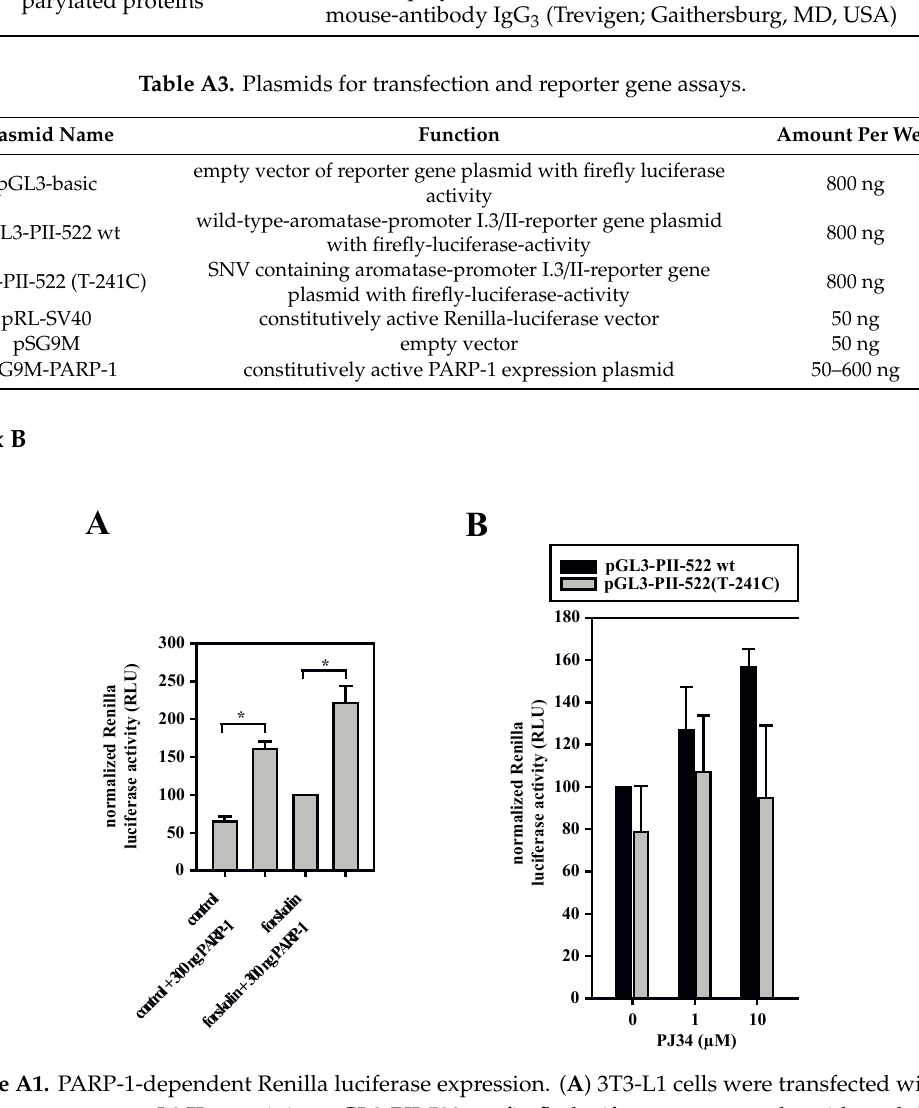
Figure A1. PARP-1-dependent Renilla luciferase expression. ( A ) 3T3-L1 cells were transfected with aromatase promoter I.3 / II-containing pGL3-PII-522 wt firefly luciferase reporter-plasmids and the Renilla luciferase pRL-SV40 reporter-plasmid. Cells were co-transfected with 300 ng pSG9M-PARP-1 expression plasmid where indicated (PARP-1). PARP-1 overexpression increased Renilla luciferase activity (n = 8; * p < 0.05). ( B ) 3T3-L1 cells were transfected with pGL3-PII-522 wt (wild-type) or pGL3-PII-522(T241C) together with pRL-SV40 plasmid expressing Renilla luciferase. In 10 µM forskolin-stimulated cells PARP-1-inhibition by PJ34 tended to increase luciferase activity in combination with wild-type-promoter I.3 / II (n =